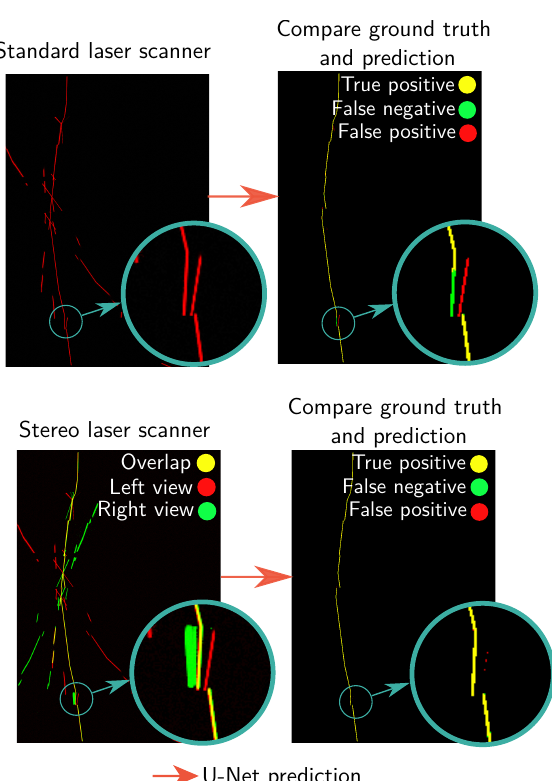
Figure 15: Specular reflection ambiguity. Sharp specu- lar reflections may have a similar appear- ance as the true laser